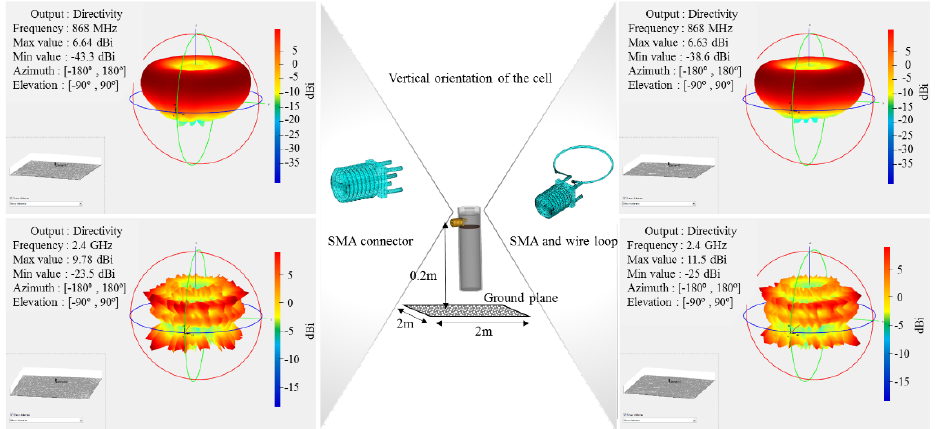
Figure 9. MATLAB 3D radiation pattern simulation for the cell’s shell radiative structure integrating the SMA and the wired loop for 868 MHz and 2.4 GHz over the ground plane in a vertical orientation.